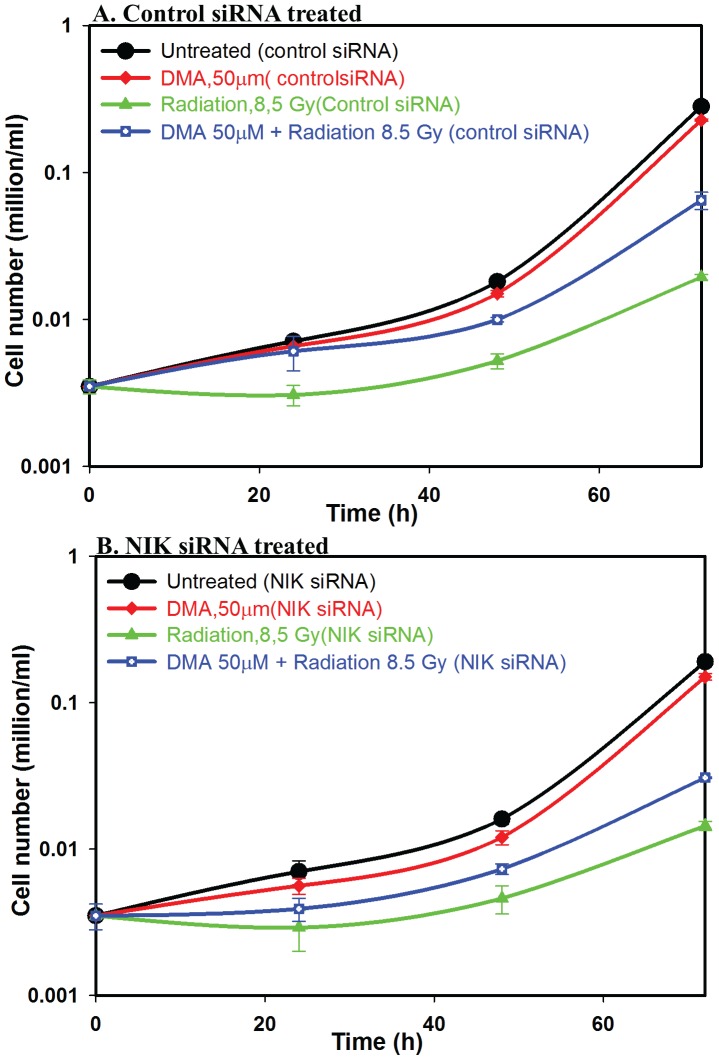
Radioprotection afforded DMA studied by proliferation kinetics assay in Control siRNA and siRNA-NIK transfectedU87 cells.(A) U87 cells (Control siRNA transfected) were treated with 50 µM DMA and 8.5 Gy Radiation. Post treatment cells were seeded in 6 well plates seeded at 8000 cells/cm2, and their proliferation kinetics was studied at 24 h intervals following trypsinization and counting total cells per well using a hemocytometer. (B) U87 Cells post siRNA-NIK oligonucleotide transfection were treated with 50 µM DMA and 8.5 Gy Radiation. Post treatment cells were seeded in 6 well plates seeded at 8000 cells/cm2, and their proliferation kinetics was studied at 24 h intervals following trypsinization and counting total cells per well using a hemocytometer. Values are mean (±SD) of three independent experiments.Statistical significance by T-test p<0.05.